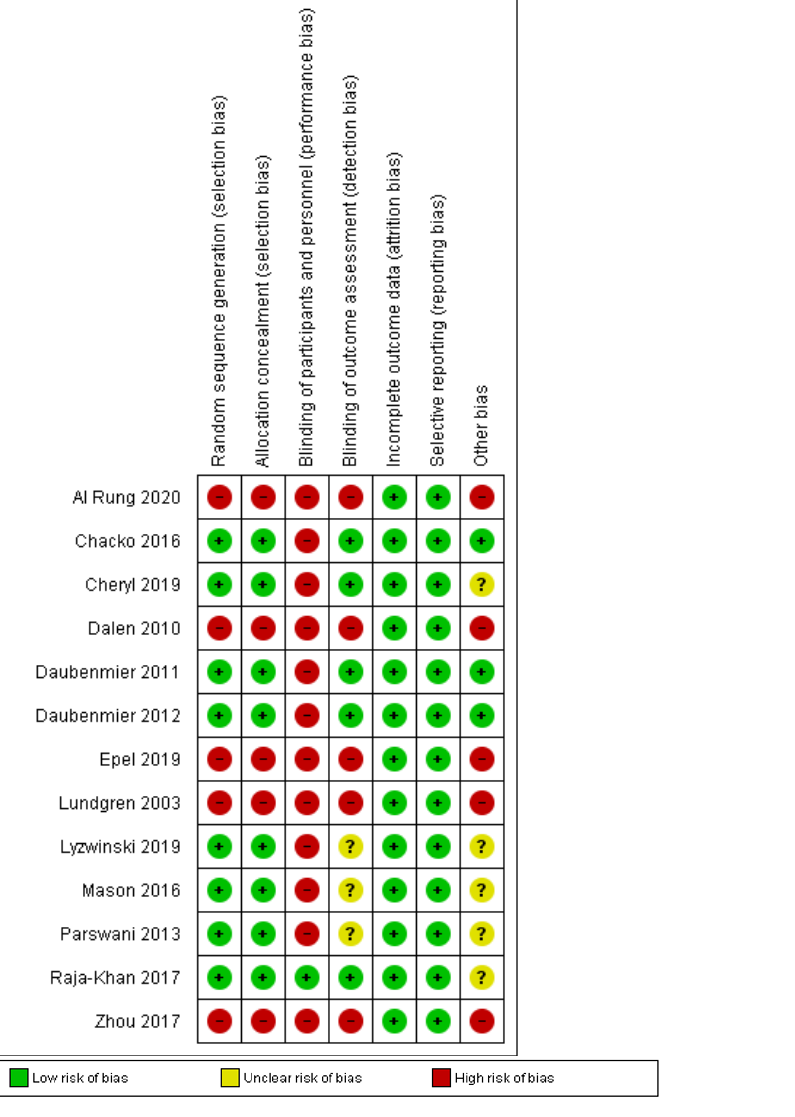
Figure 3. Summary of risk of bias: reviewers’ judgments of each element of risk of bias for each included study ([10,13,24 – 33,35]).